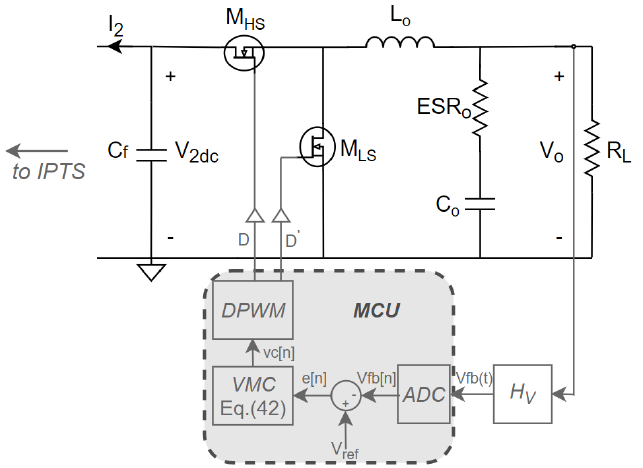
Figure 19. DVMC of the buck converter.